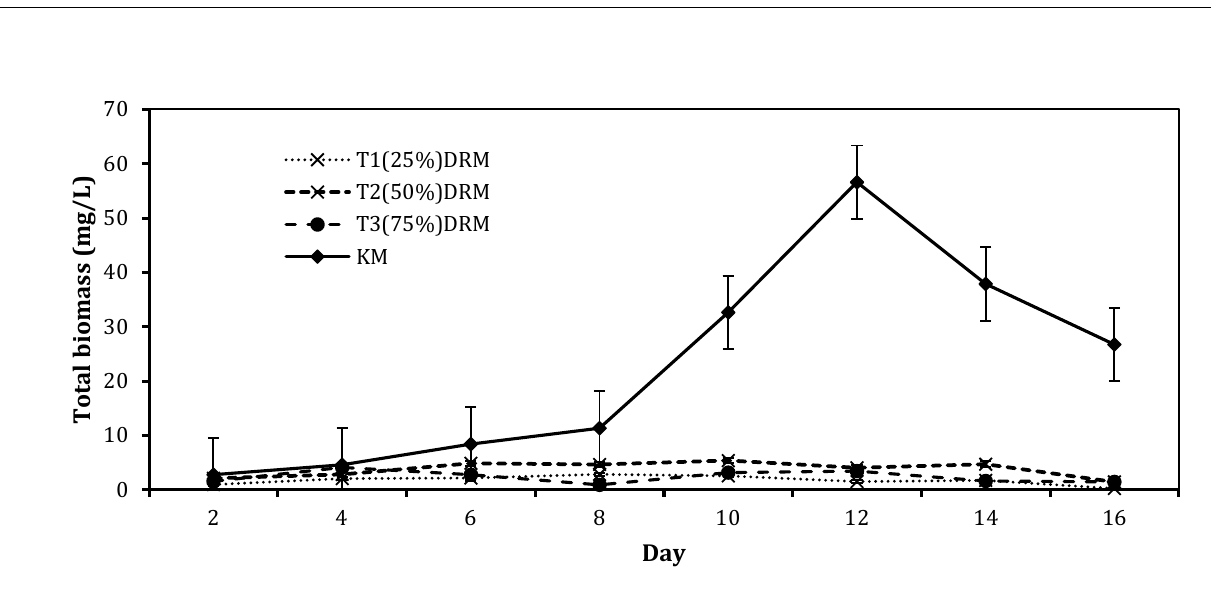
Figure 4: Mean values of total biomass (mg/L) of S. platensis grown in supernatant of three different digested rotten mangoes, and KM. Vertical bars represent standard